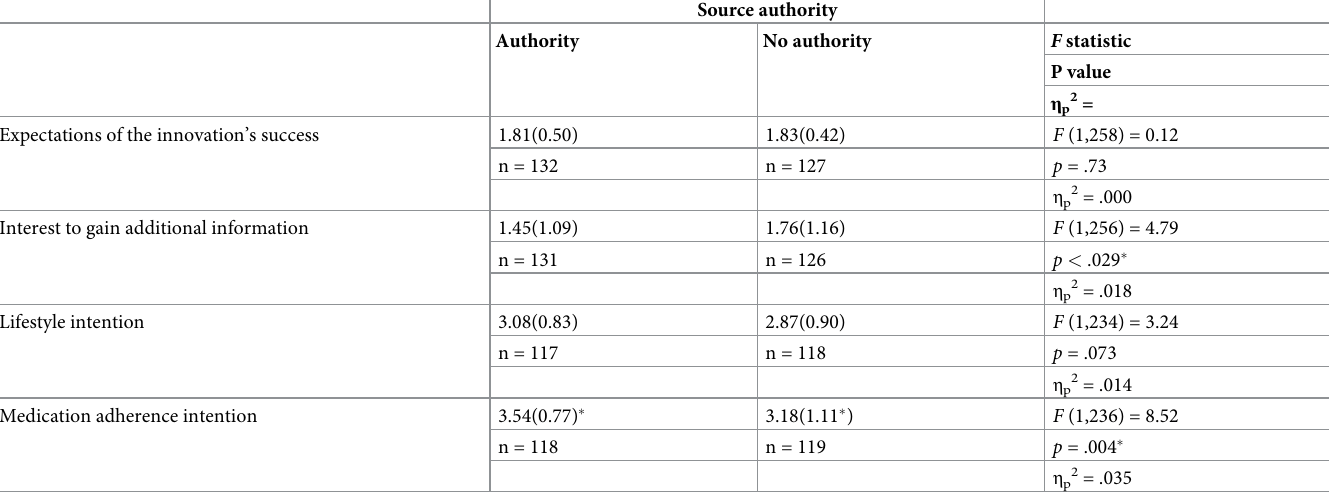
Table 5. Results one-way ANOVA: between group differences as filled in on a 5 point likert scale 0–4; mean/neutral = 2.0 (Source